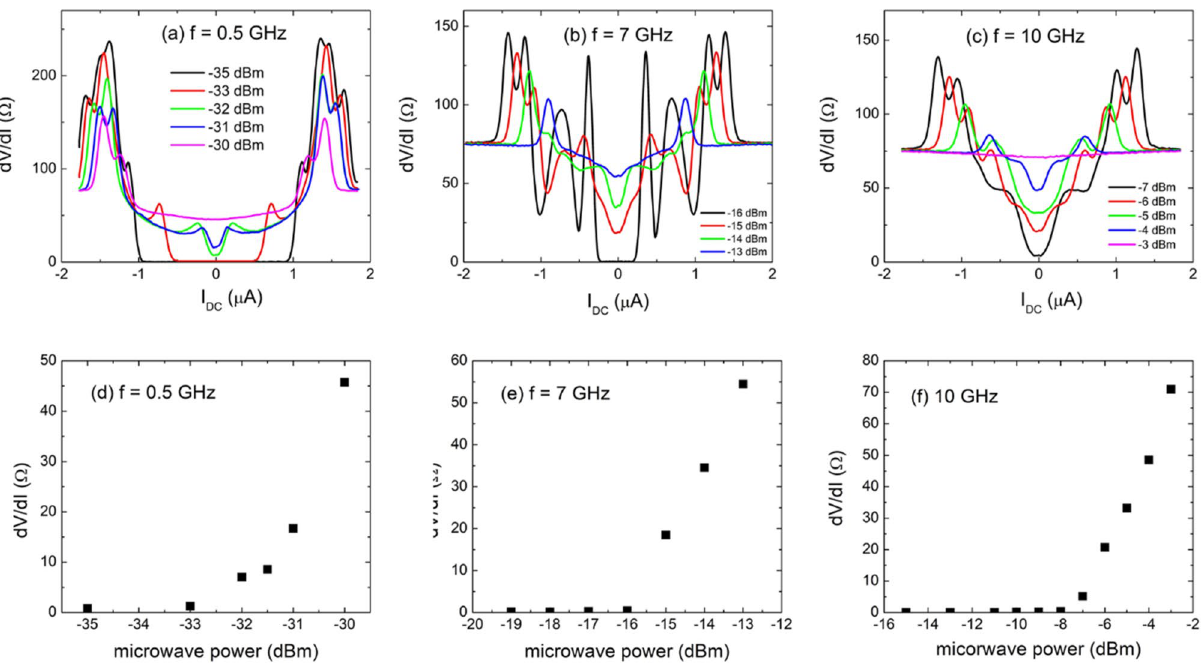
Figure 2. ( a – c ) The differential resistance measured at three selected microwave frequencies, 0.5, 7, and 10 GHz. At each frequency, the microwave power is also varied. ( d – f ) The zero-bias resistance as function of microwave power at 0.5, 7, 10 GHz,